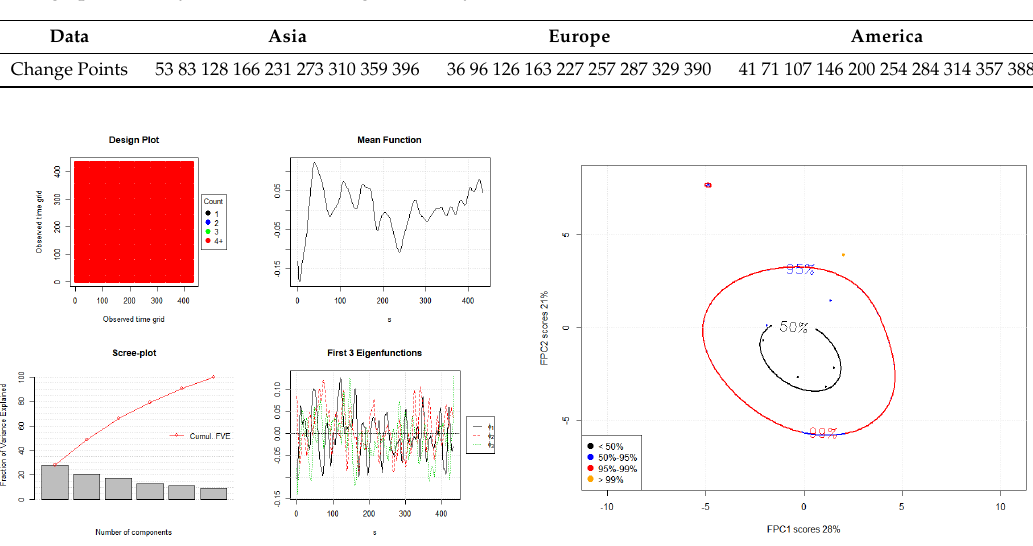
Figure 6. FPCA plots of Asia (1/3/2013 to